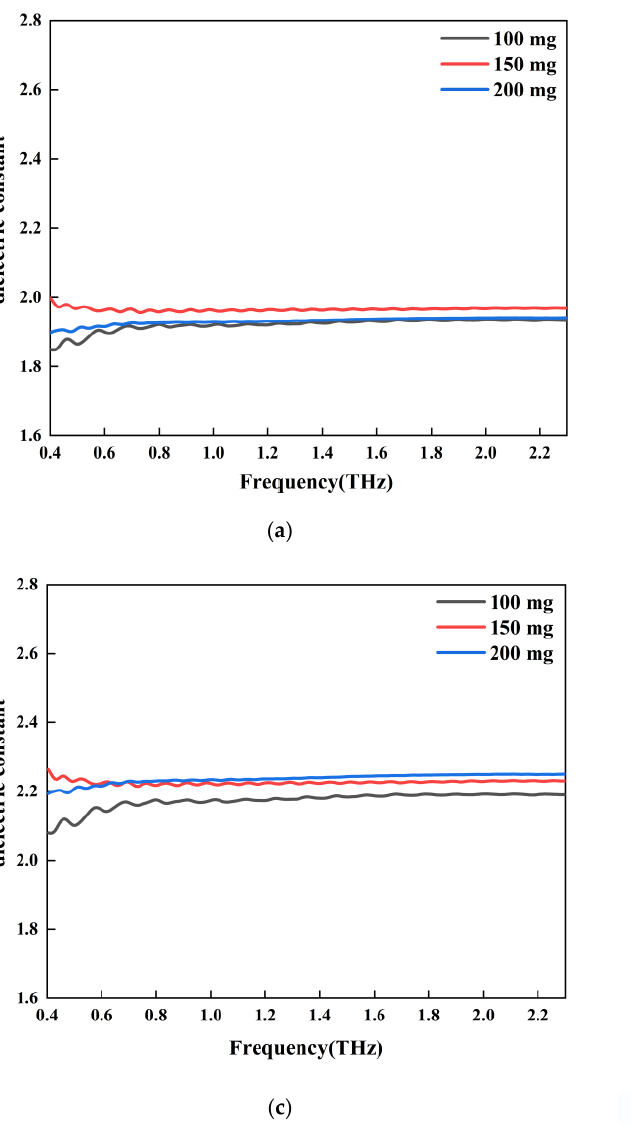
Figure 11. Dielectric constant of a mixture of C 3 S and PE: (a) experimental measurement of dielectric spectra of mixtures; (b) average dielectric constant in the 0.4 – 2.3 THz range. To verify the experimental results, we used three EMT models to calculate the die- lectric constant of each sample. The intrinsic dielectric constants of C 3 S and PE were 6.51, 6.61, and 6.73, and 2.17, 2.16, and 2.17, respectively, as determined in Section 5.2. Figure 12 shows comparisons between the measured dielectric constant and the calculated die- lectric constant using the three models. As shown in Figure 12a – c, the calculated values agreed with the measured values. The R-squared values for the MG, BM, and LLL models were 0.9774, 0.9782, and 0.9809, respectively. Using Equation (9), we calculated the rela- tive errors, as shown in Figure 12d, to be 3.86%, 3.30%, and 2.98% for the MG, BM, and LLL models, respectively. Therefore, the LLL model was the best for fitting the THz die- lectric constants of the samples. Both the MG and the B models were derived by assuming that the guest phase was spherical. However, the LLL model did not have this limitation. In addition, this model is suitable for low-dielectric-contrast composites because it em- ploys Taylor approximation [20]. The dielectric contrast between C 3 S and air is relatively small, which may explain why the LLL model performed better than the other two models. ( a )